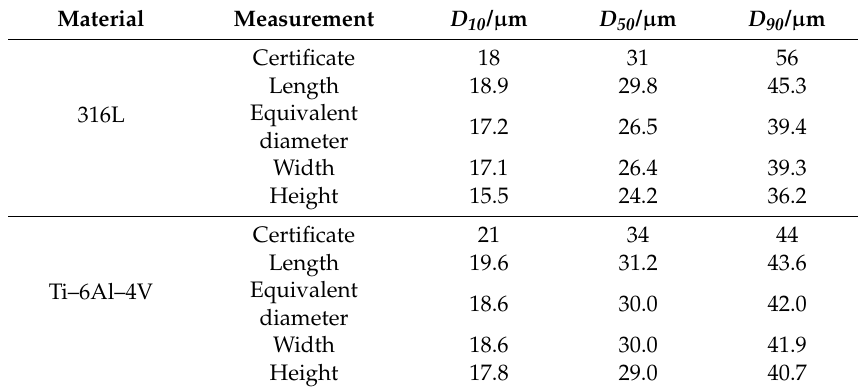
Figure 5. Volume weighted cumulative frequency for Ti–6Al–4V (blue) and 316L ( red ) based on CT analysis in comparison with the certificated values for D 10 , D 50 , and D 90 ( filled circles ) Table 1. Comparison of volume-weighted powder particle size distributions obtained by laser diffraction (LD) and by CT. Material Measurement